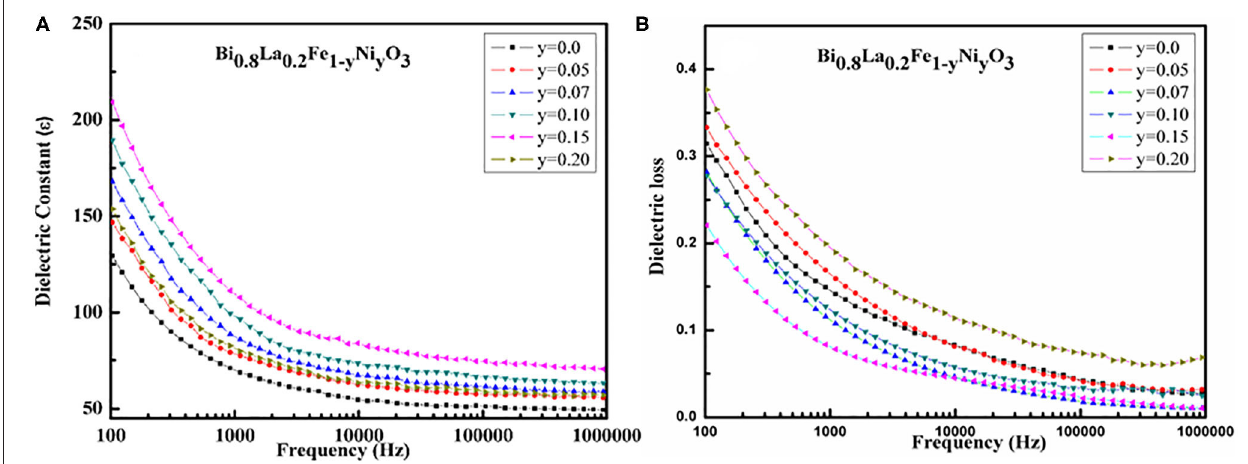
FIGURE 6 | (A) Variation of dielectric constant with frequency for Bi 1 dielectric loss, with frequency for Bi 1